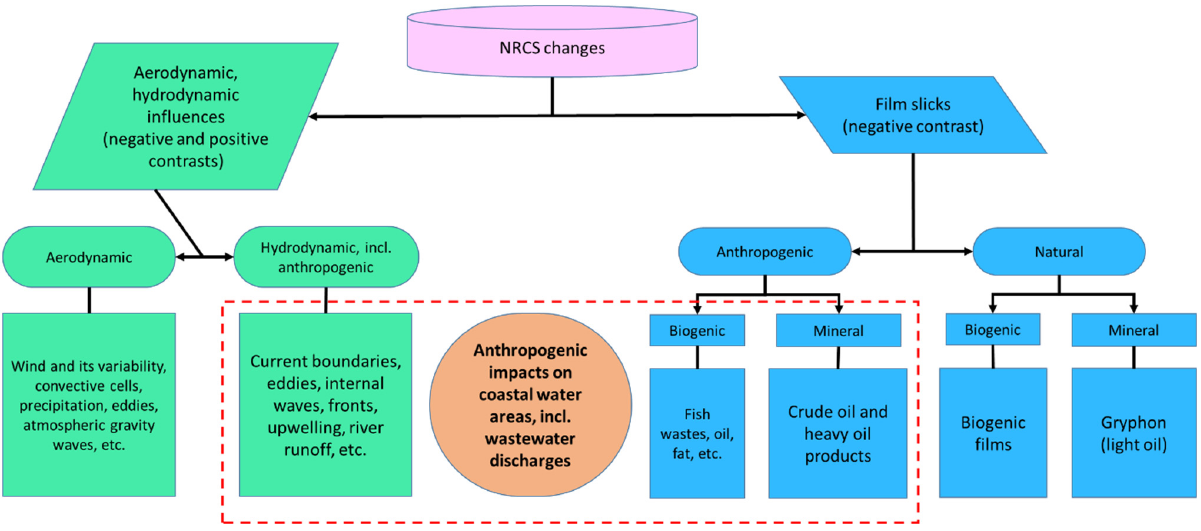
Figure 3. Classification of areas with NRCS changes which was used for revealing anthropogenic impacts on coastal water areas (the red outline shows phenomena of interest).